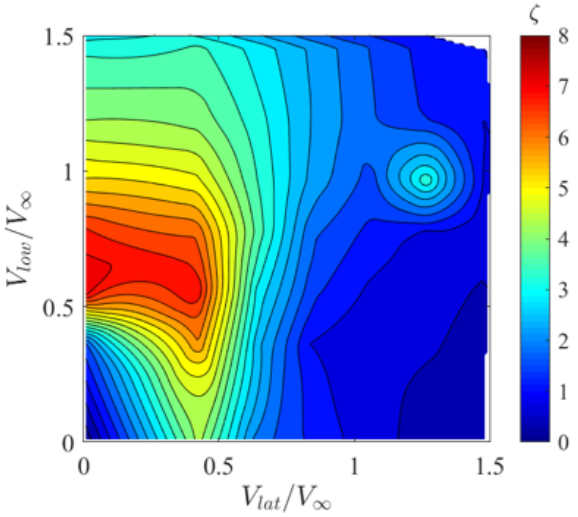
Figure 10. Efficiency ζ of the flow actuation system as a function of the blowing speed of the lower ( V low / V ∞ ) and lateral ( V lat / V ∞ ) jets.